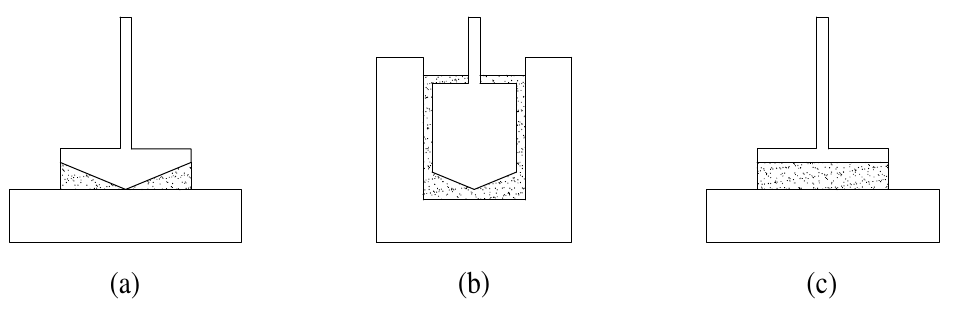
Figure 2. Schematic representation of different rheometer geometries; ( a ) cone and plate, ( b ) concentric—cup and bob, ( c ) parallel plate.